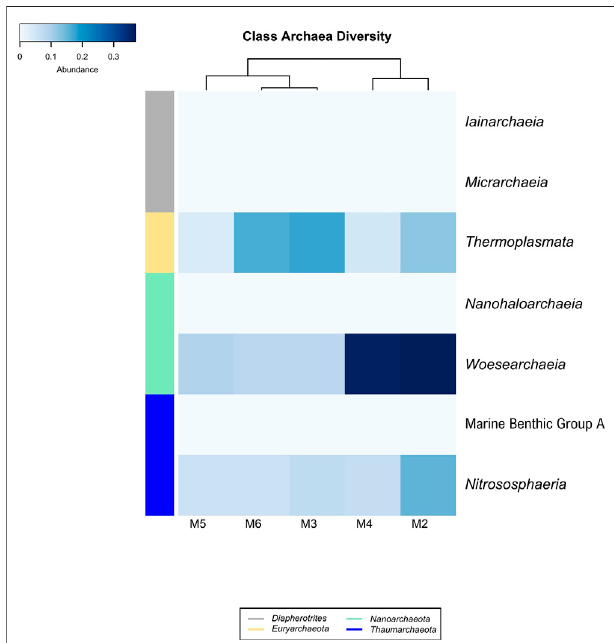
FIGURE 5 | Heat-map analysis of Morgana Cave archaeal community relative abundance at class level. The identi fi ed groups are presented in the right column and their phylum level indicated in left-colors